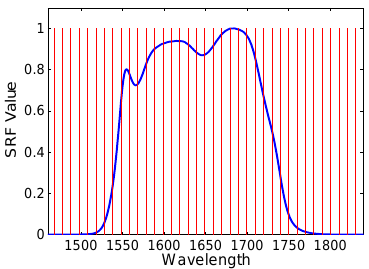
Figure 3: Spectral response function of band 9 of ALI to detect. In other words, all the wavelengths that a sensor is able to detect contributes to its value. The weight of the contribution of a particular wavelength is determined by the SRF value at that wavelength. Ideally, to simulate a multispectral band, we need light from all wavelengths within the SRF of that band. But this level of spectral detail is not available in real sensors. Hyperspec- tral sensors are the closest approximation for the data that can be used for simulating a sensor with wide SRF. As mentioned be- fore, SRFs of hyperspectral bands are generally referred by their center wavelengths as they are very narrow. Figure 3 shows these center wavelengths as vertical red lines. The hyperspectral bands that contribute in simulation of a multispectral band are the ones which have their center wavelength within the spectral range of the multispectral band. Table 1 shows the set of hyperspectral bands selected for each multispectral